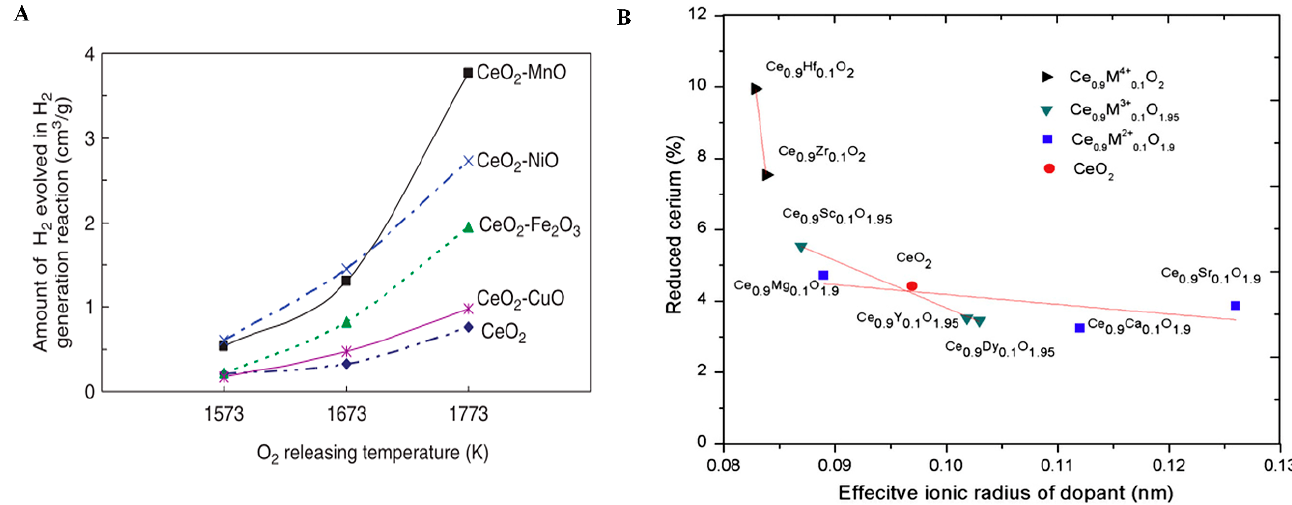
Figure 4. ( A ) Correlation between O 2 -releasing temperature and the amount of hydrogen produced in the reaction with CeO 2 –MO x . Reprinted with permission from Ref. [65] , copyright 2007, Elsevier. ( B ) Effect of effective ionic radius and valence state of dopants on the reduction degree of cerium. Reprinted with permission from Ref. [66] , copyright 2011, Elsevier.